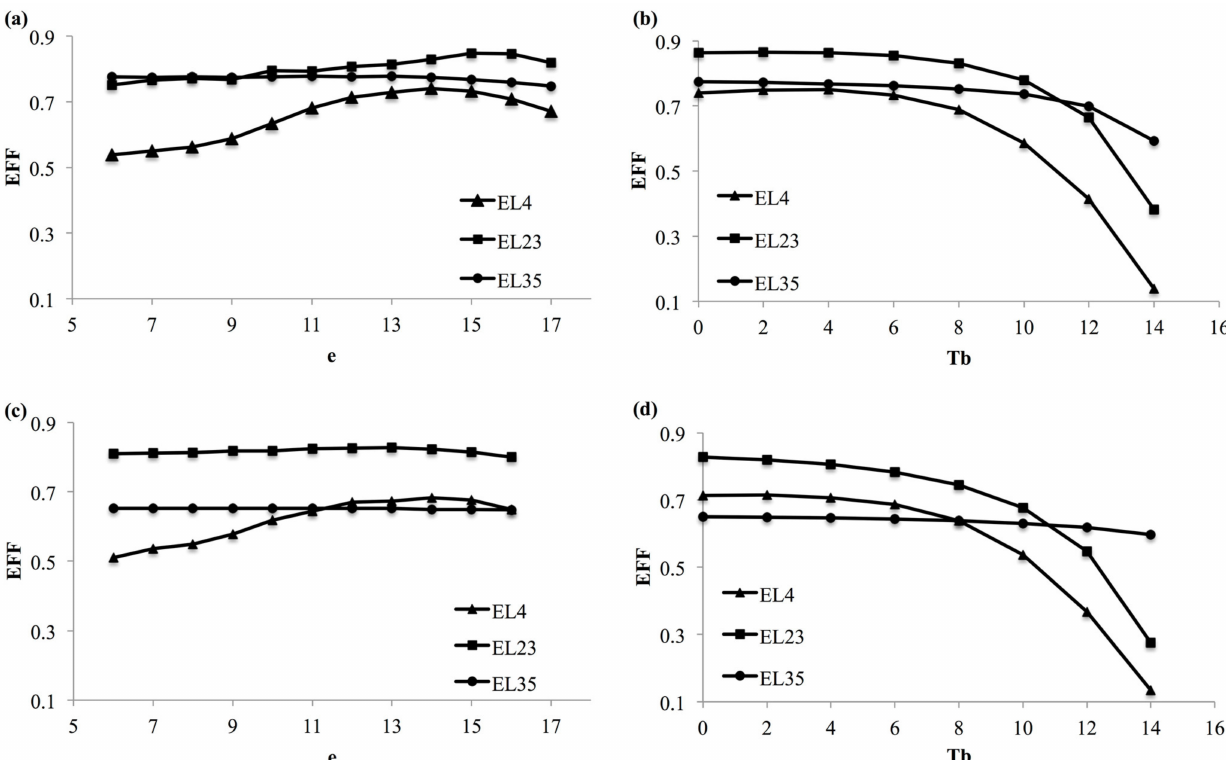
Figure 4. Variation in the global efficiency (EFFg—mean of model EFF of the four maturity stages MS 0.75 , MS 1 , MS 1.5 , and MS 2 ) as a function of the e coefficient of the SM model, for ( a ) TN and ( c ) EN, and as a function of the T 0 coefficient of the DD model, for ( b ) TN and ( d ) EN, with starting dates EL4 (budbreak), EL23 (flowering), and EL35 (beginning of